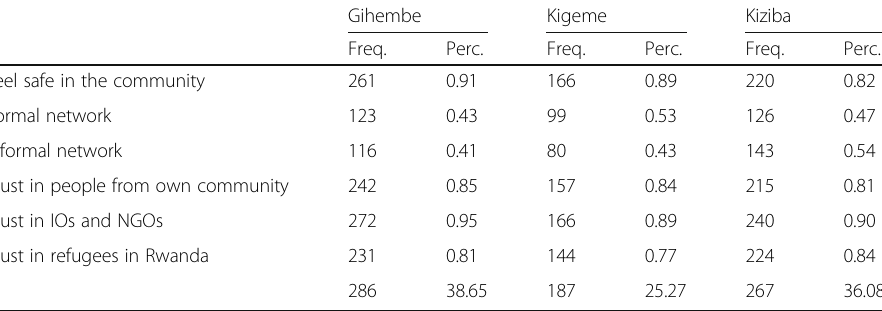
Table 4 Descriptive differences in outcome variables, by closest refugee camp Gihembe Kigeme Kiziba Freq. Perc. Freq. Perc. Freq.